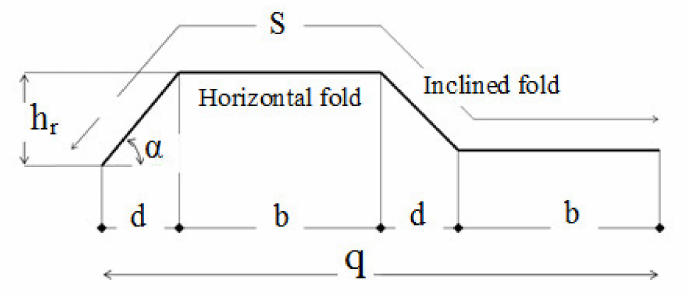
Figure 1. Corrugated web: profile configuration.